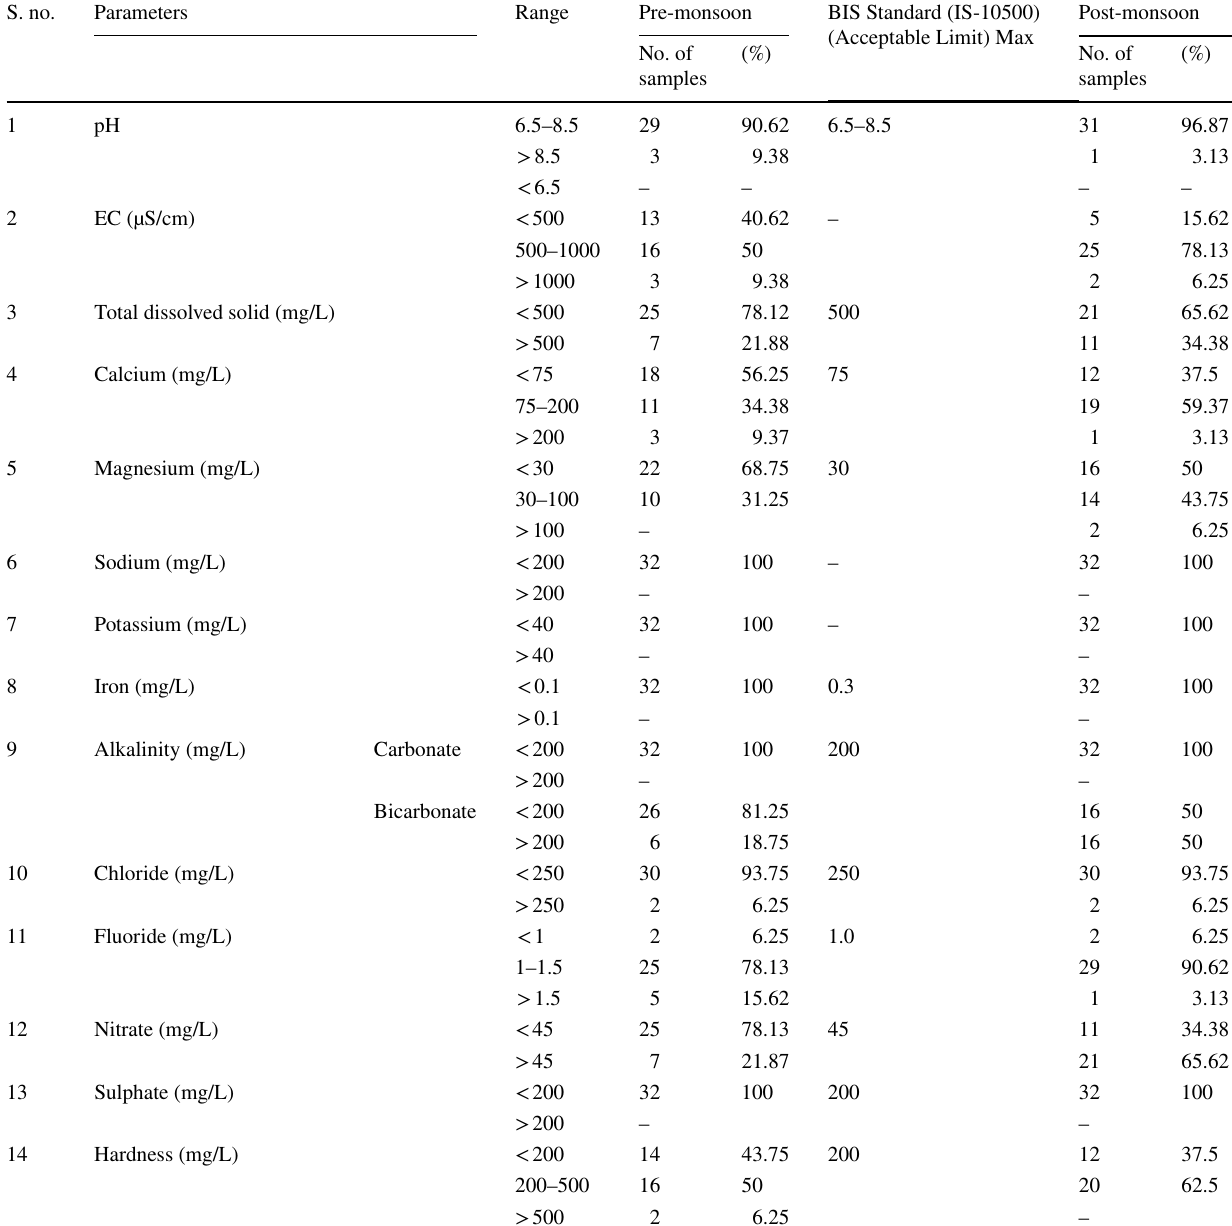
Table 3 Suitability of drinking water in the study area as per BIS-2012 (IS-10500) S.